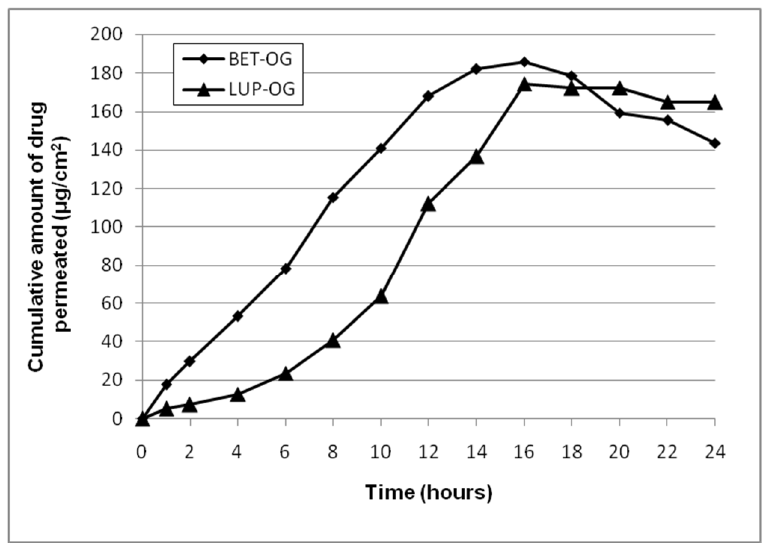
Figure 4. Ex vivo betulin and lupeol permeation profiles through pig ear skin from oleogel formu- lations. Table 4. The permeation and release parameters of active compounds from oleogel formulations through pig ear skin a and the amounts of active compounds accumulated in the skin samples. Permeation Parameters Formulation